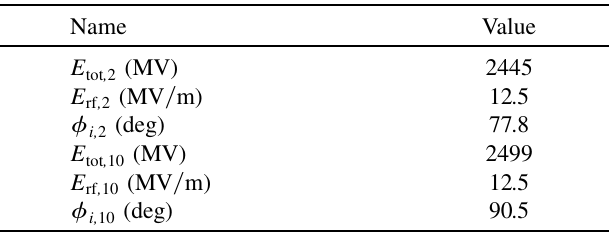
TABLE II. Radio-frequency system parameters for bunch compression simulations (90 (cid:2) on crest).